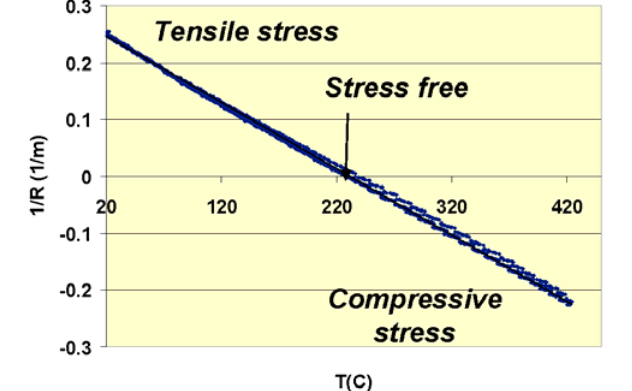
Figure 9. Curvature of the bonded stack as a function of